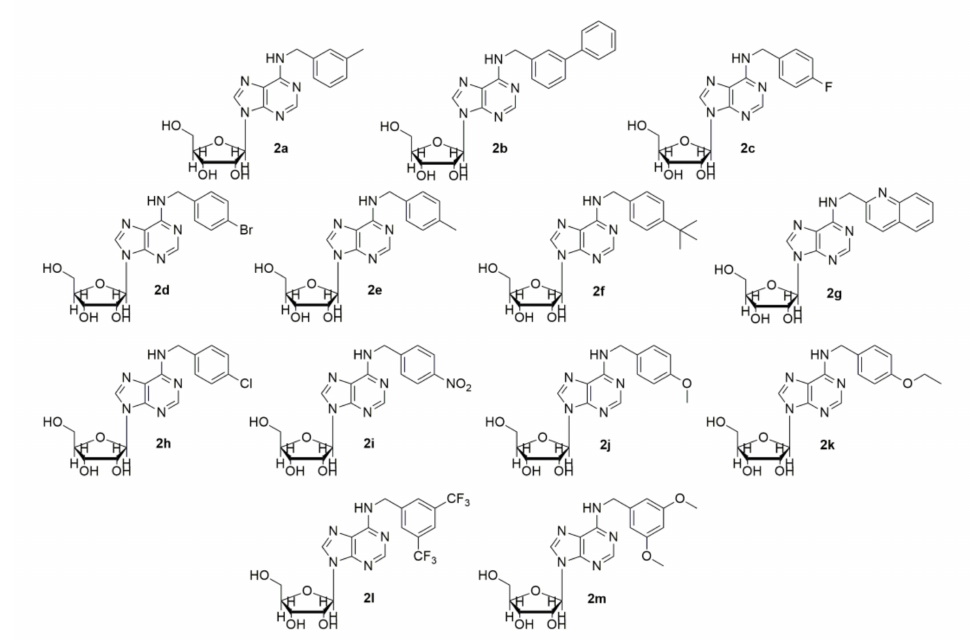
Figure 2. Chemical structures of N6-benzyladenosine derivatives ( 2a–m